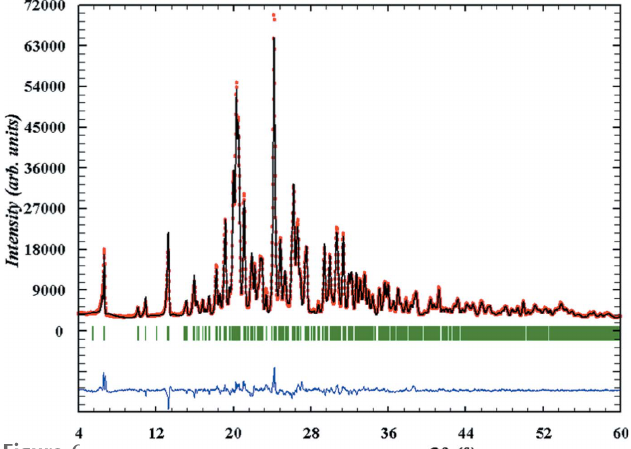
Figure 6 Final Rietveld plots for the title compound. Observed data points are indicated by red circles, the best-fit profile (black upper trace) and the difference pattern (blue lower trace) are shown as solid lines. The vertical green bars correspond to the Bragg